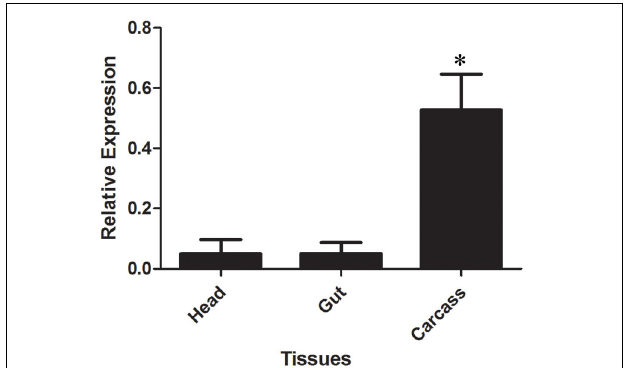
FIGURE 9 | Relative expression of i-type lysozyme (LlLysi) in different tissues of Lutzomyia longipalpis L4 larvae as determined by Multiplex RT-PCR (Ribosomal protein 60 used as constitutive gene). Bars represent the mean ± SE from 5 independent experiments. The statistics were done using ANOVA with Turkey post-test and student’s t -test. Asterisks indicate statistically significant differences in the samples.